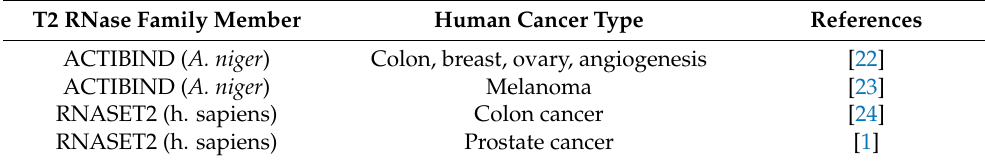
Table 1. Published articles reporting a tumor suppressive role for T2 RNases in human cancer types. T2 RNase Family